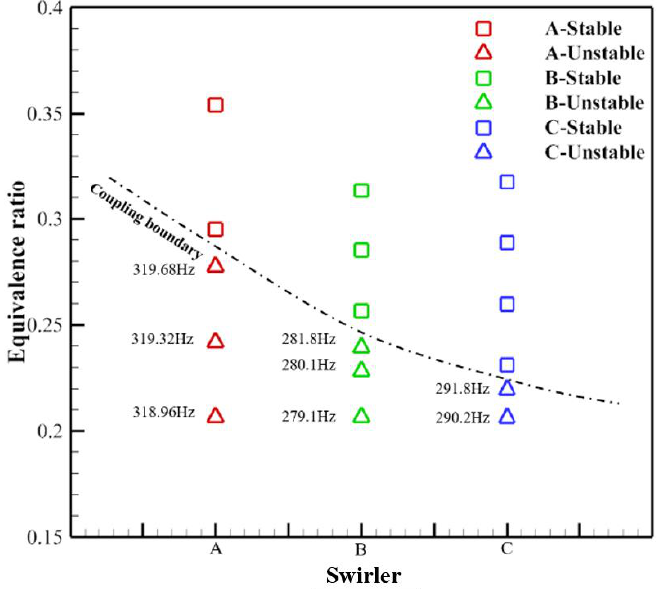
Figure 7. Influence of swirler scheme and equivalence ratio on combustion state.